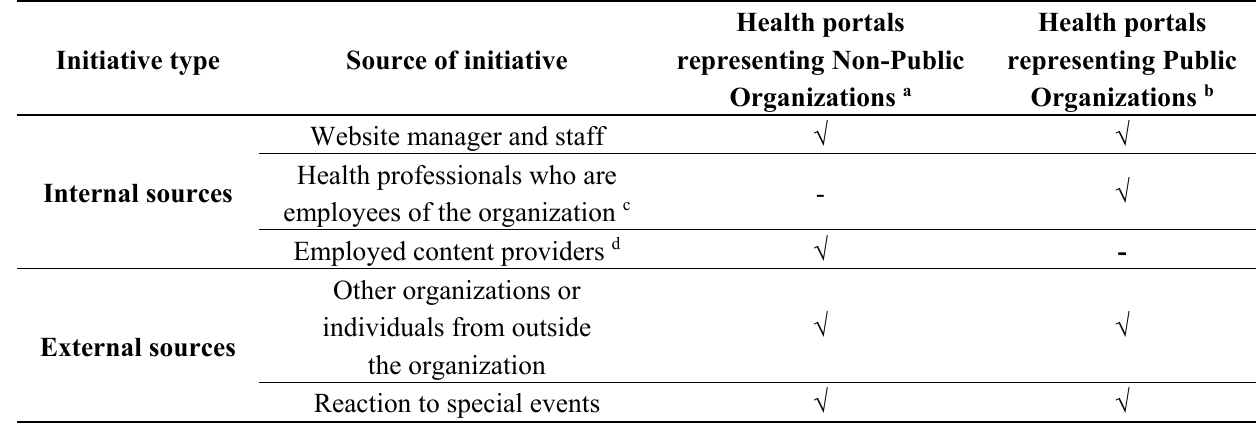
Table 3. Sources that initiate the production and publication of content on health websites by types of